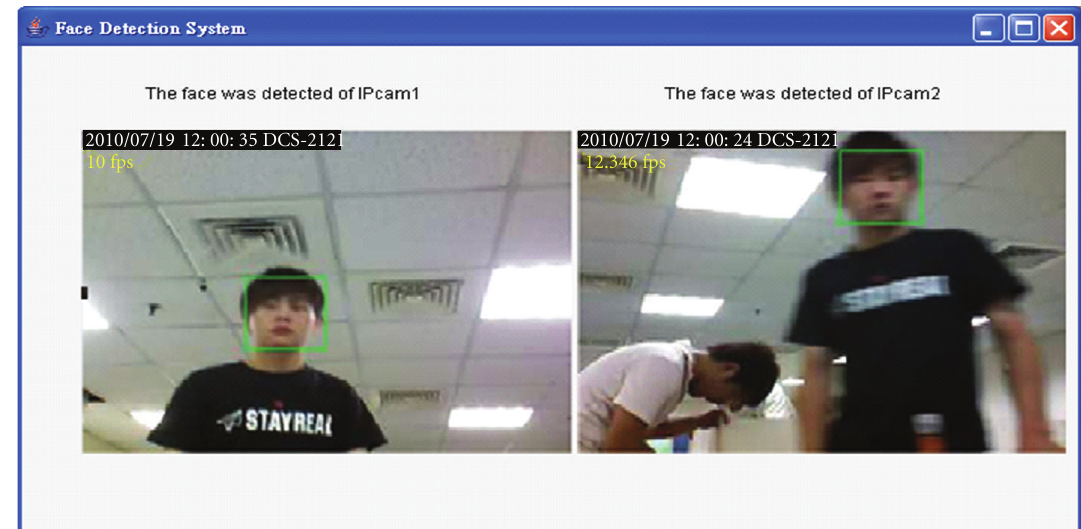
Figure 12: Face detection application program.